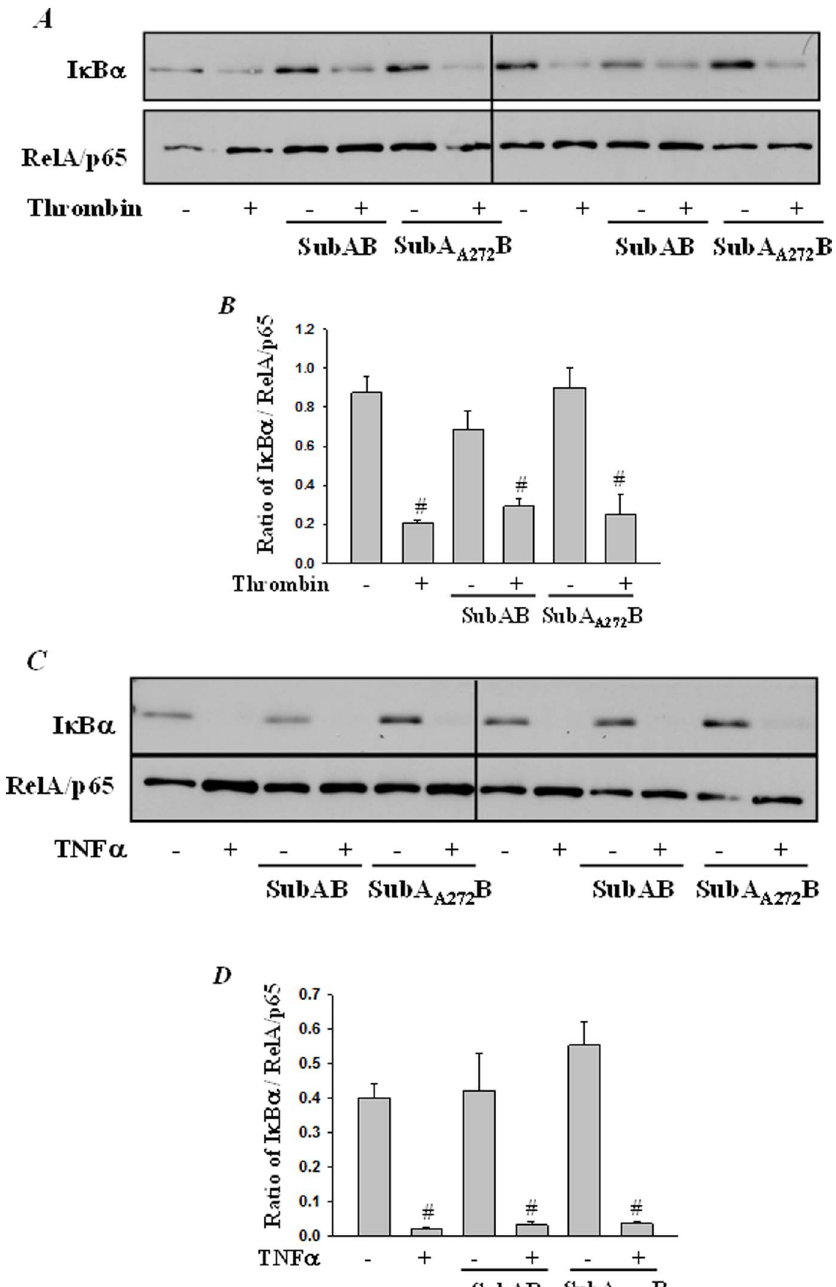
Figure 12. SubAB failed to block thrombin-induced I k B a degradation. HPAEC were treated with 0.1 m g/ml of SubAB or mutant SubA A272 B for 6 h, followed by treatment with ( A ) thrombin (5 U/ml) for 1 h or with ( C ) TNF a (100 U/ml) for 30 min. Total cell lysates were prepared and immunoblotted with anti-I k B a antibody to determine degradation of I k B a . Levels of RelA/p65 was used to monitor loading. The bar graphs represent the effect SubAB and SuBA A272 B on ( B ) thrombin-induced or ( D ) TNF a -induced I k B a degradation normalized to total RelA/p65 levels. The data are the means 6 S.E. (n=3–6 for each condition). # p , 0.05 difference from controls.